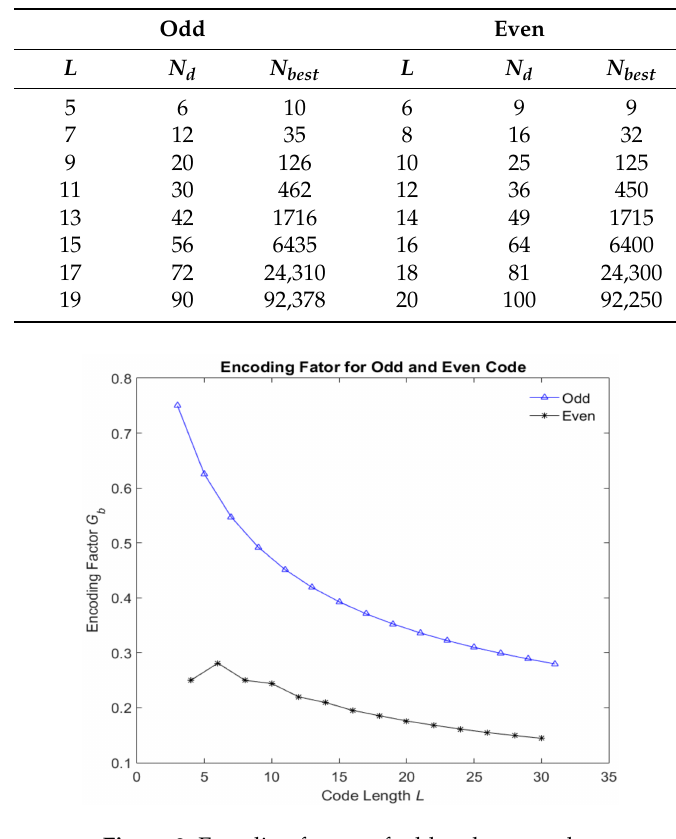
Figure 9. Encoding factors of odd and even